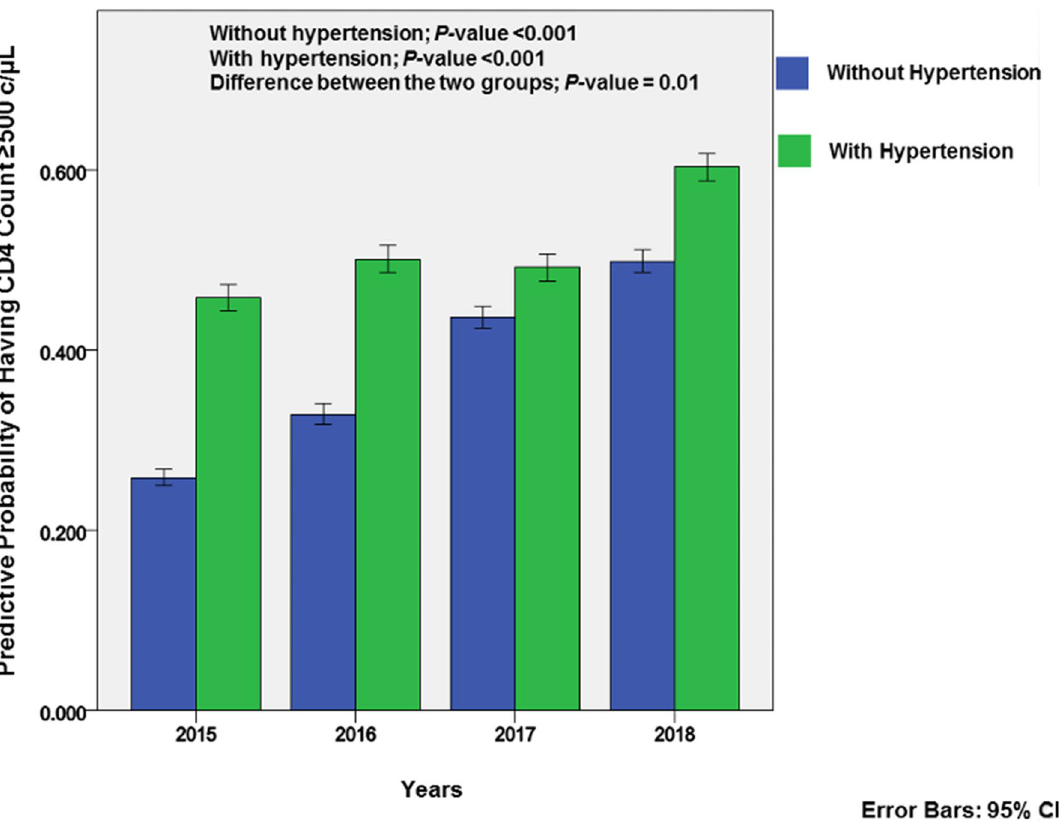
Figure 3. Predictive probability in relation to CD4-Cell